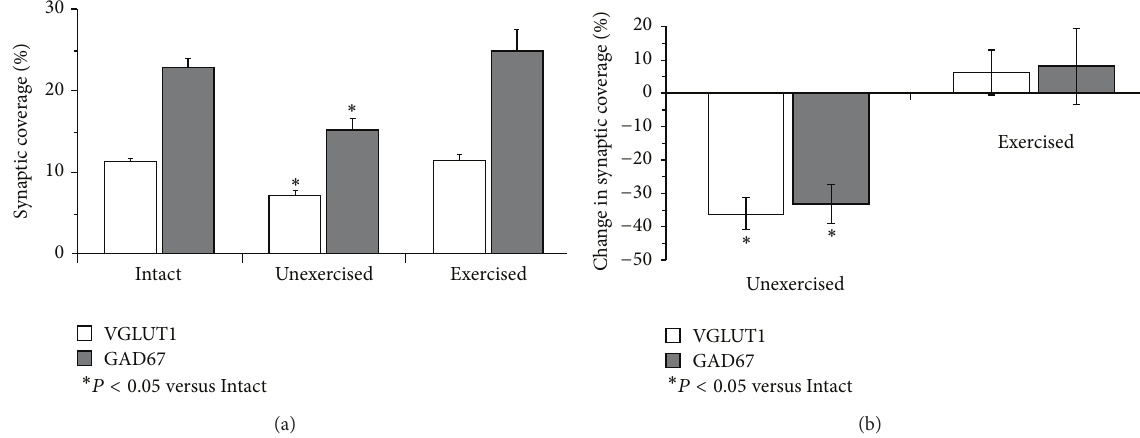
Figure 2: (a) The mean ( ± SEM) percent coverage by synaptic structures contacting motoneuron somata and proximal-most dendrites is shown for intact wild-type mice and two weeks after transection of the sciatic nerve, in unexercised mice and mice exercised daily, five days per week during that period. Data are shown for synaptic contacts that were immunoreactive for VGLUT1 (white bars) or GAD67 (grey bars). (b) The same data as in (a) are plotted as the mean ( ± 95 confidence interval) percent reduction in synaptic contact, relative to intact mice. 𝑛 = 11 for intact, 𝑛 = 8 for unexercised, and 𝑛 = 9 for